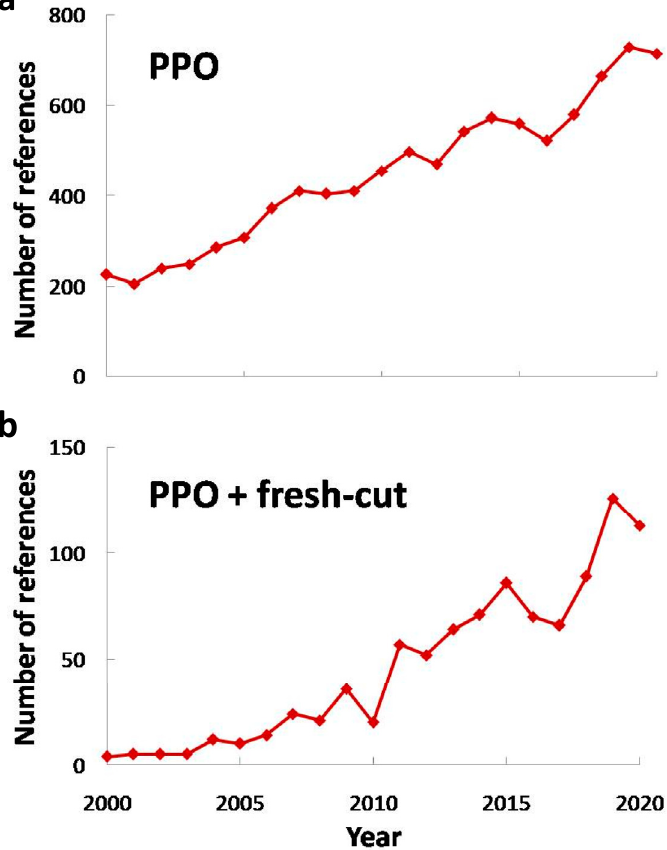
Figure 2. References related to: “PPO” and “PPO + fresh-cut”